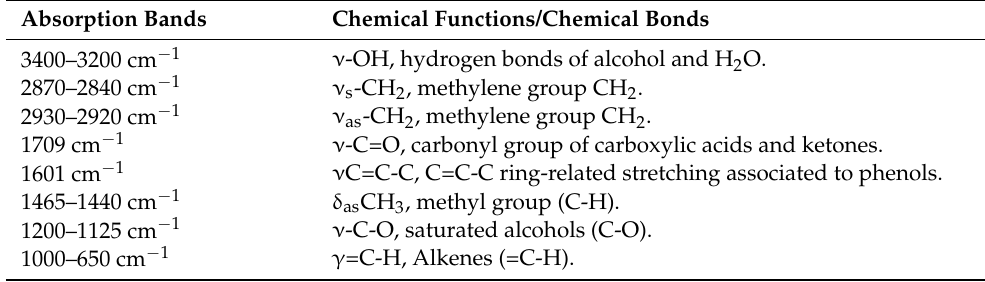
Figure 7. FT-IR analysis of bio-oils obtained by pyrolysis of Açaí seeds (Euterpe Oleracea, Mart), activated with 2.0 M KOH solution, at 350, 400, and 450 °C, 1.0 atmosphere, in laboratory scale. Table 3. Absorption bands and chemical functions/groups identified by FT-IR analysis of bio-oils obtained by pyrolysis of Açaí seeds, activated with 2.0 M KOH solution, at 350, 400, and 450 °C, 1.0 atmosphere, in laboratory scale.